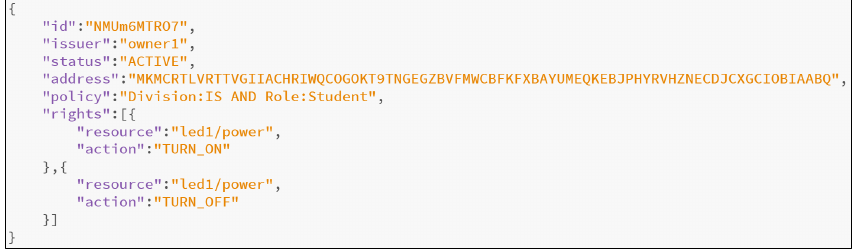
Figure 6. Example of a